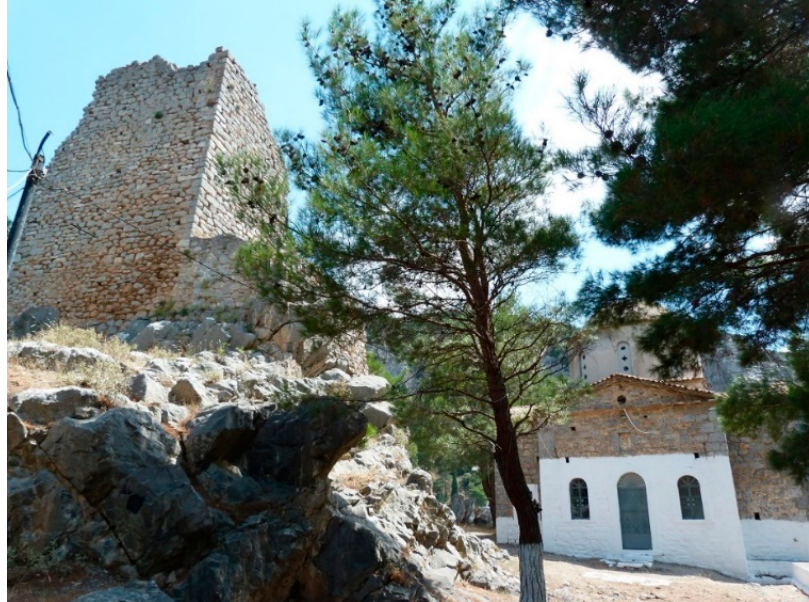
Figure 29. Castle of Livadia (Boeotia), the keep and the churches of Hagia Sophia and Hagia Barbara. ©